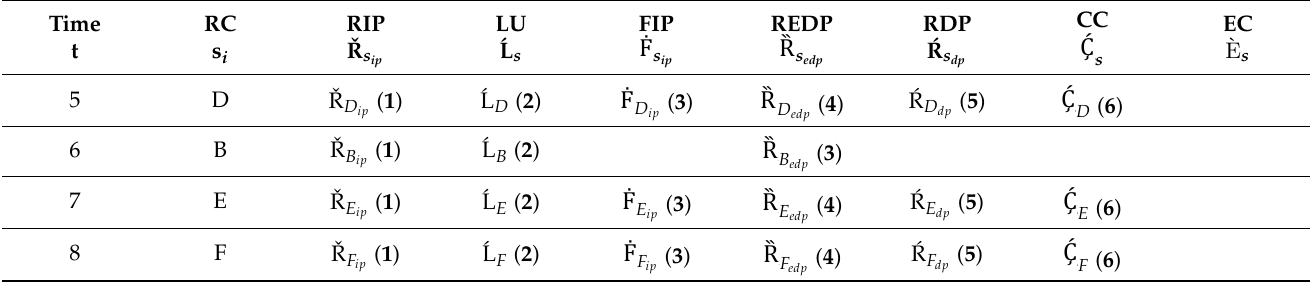
Algorithm 2: IMU Replacement